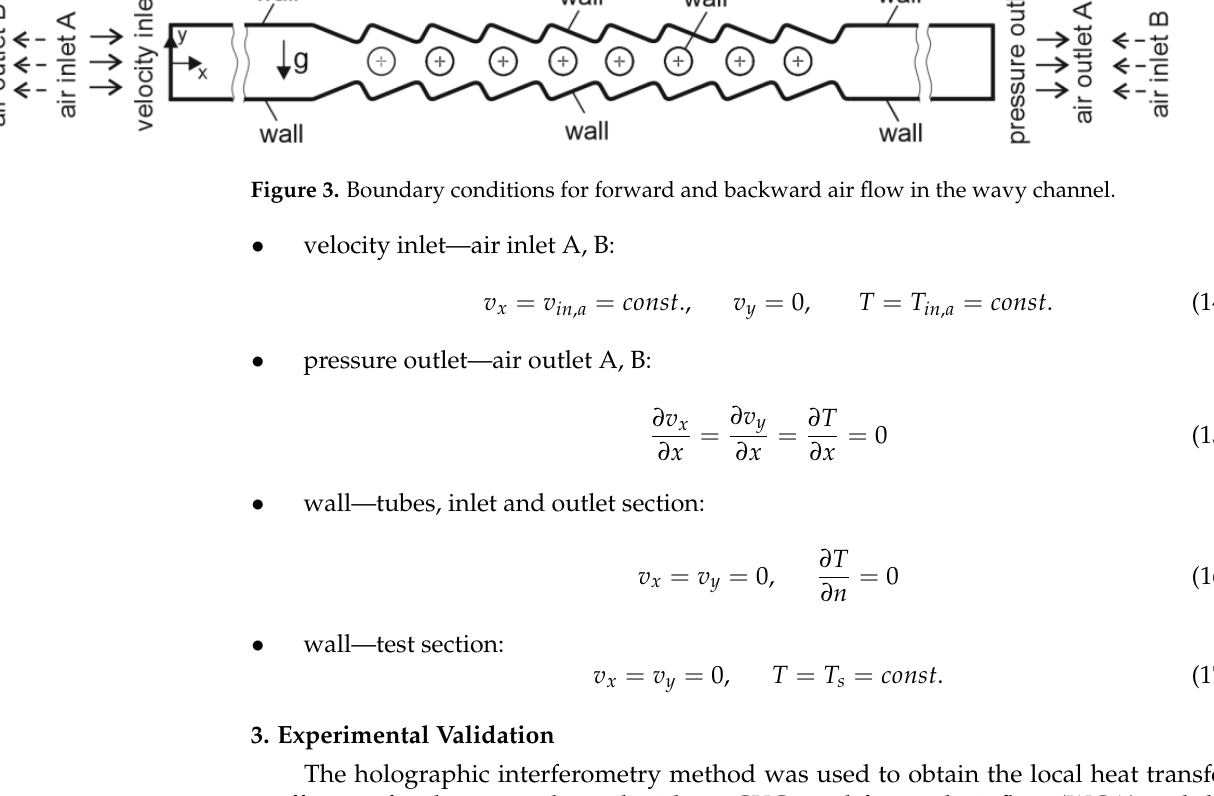
Figure 4. Comparison between the experimental and numerical local heat transfer coefficients for H = 40 mm, T s = 318.15 K, Q = 5 – 20 m 3 /h, ( a ) wavy channel without CVGs, ( b ) wavy channel with CVGs of 15 mm diameter.